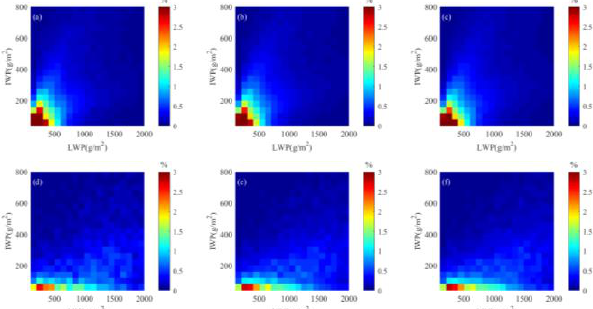
Table 1. The statistic result for precipitation of selected TCs